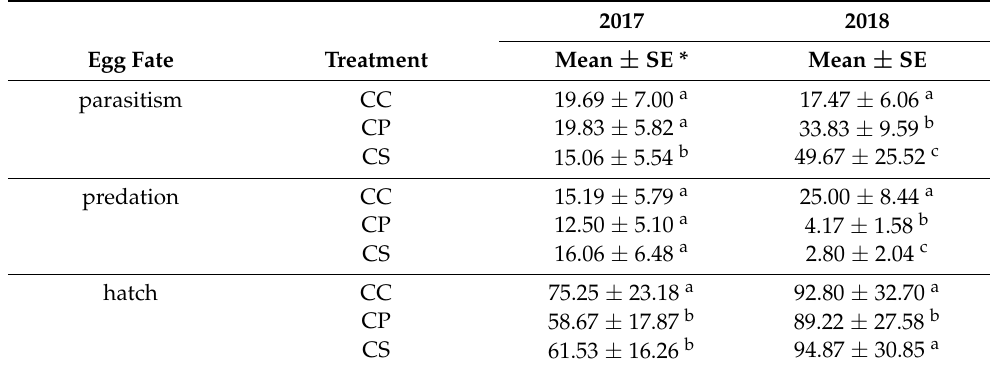
Table 4. Percentage of stink bug egg mortality due to parasitism and predation, and proportion of hatched individuals in soybean during 2017 and 2018, at one field site, Beltsville [Central Maryland (CM)], across three post-harvest treatments following corn harvest. For the three treatments, CC denotes cover crop planted in corn residue/stubble; CP represents chisel plowed (conventional tillage) plot; and CS (corn stubble) no action.